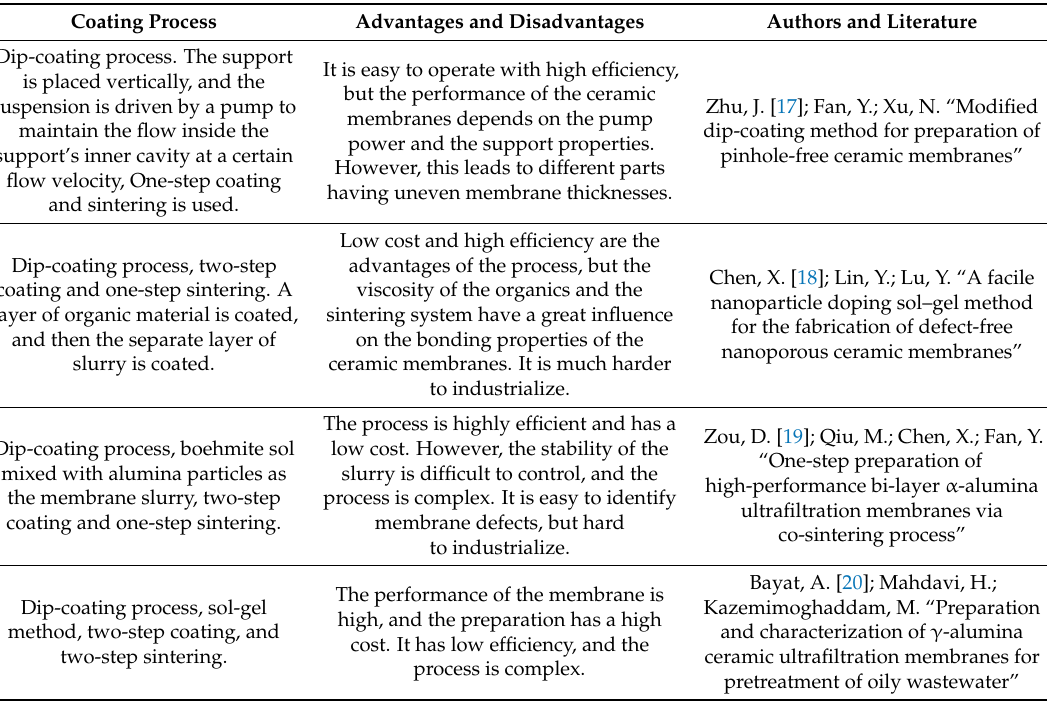
Table 1. Preparation process of ceramic